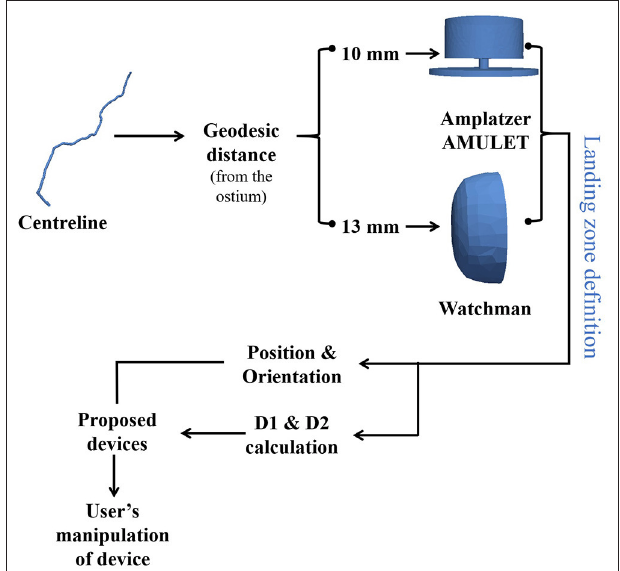
FIGURE 3 | Computational pipeline to obtain optimal left atrial appendage occlusion (LAAO) device configuration. Device positioning (e.g., landing zone) is initially estimated at a certain geodesic distance from the ostium following the LAA centreline (10 and 13 mm for the Amplatzer Amulet and Watchman, respectively). Device orientation is set perpendicular to the LAA centreline. LAAO size is based on the maximum diameters (D1 & D2) of a transversal 2D plane perpendicular to the centreline placed in the optimal positioning. The proposed LAAO devices are initially shown in the VIDAA platform with these settings (VIDAA-init), where the clinician can interactively manipulate all their parameters for a better fitting to the studied LAA morphology